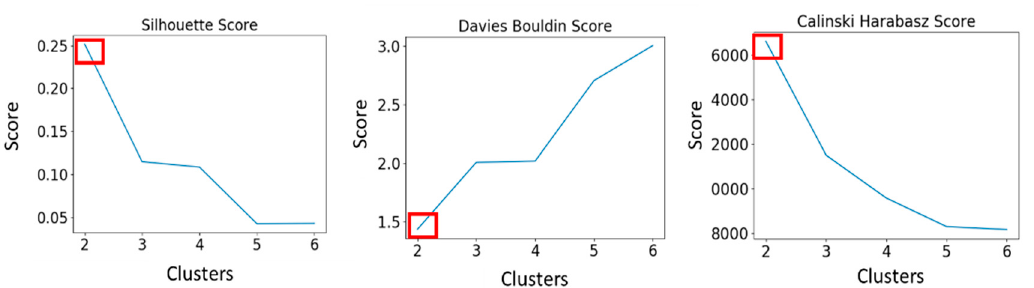
Figure 6. Variance per principal component.